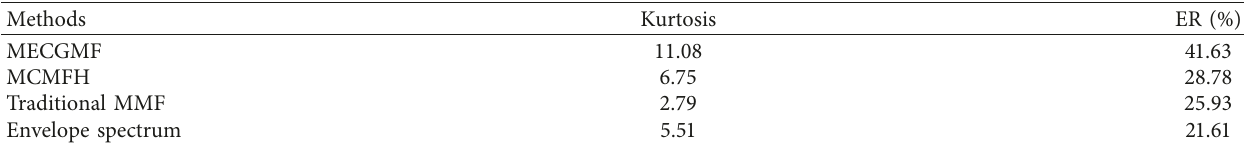
Figure 16: Case 1: waveform and spectrum of the MCMFH filtering result: (a) time-domain waveform; (b) amplitude spectrum. Table 4: Case 1: comparison results of the MECGMF, MCMFH, traditional MMF, and envelope